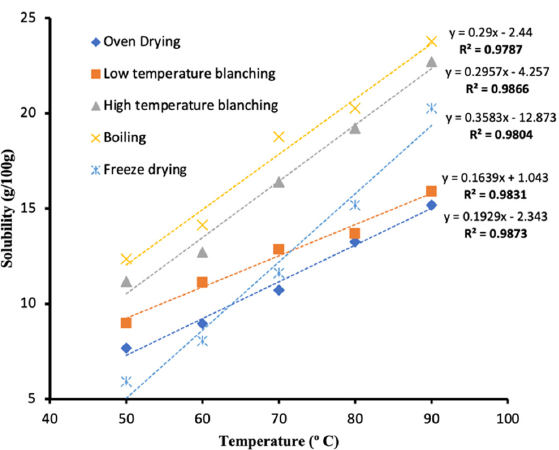
Figure 5. Solubility index of different potato flours at different temperatures. The solubility of the flour increased with increasing temperature for all the samples. There was a strong positive correlation for solubility with increasing temperature (R 2 > 0.98). The highest solubility index was observed for high ‐ temperature processed samples (boiling and blanching at 95 °C) compared to freeze ‐ dried and low ‐ temperature blanching flour. These results agree with Kim and Kim [67], who reported an increase in solubility of potato flour with increasing temperature. The high solubility values reported in this study would be attributed to the high soluble content and leaching of amylose from starch [68]. Song et al. [69] reported that if flour or starch shows high solubility compared to others, it contains large amounts of soluble materials. High temperatures weaken the